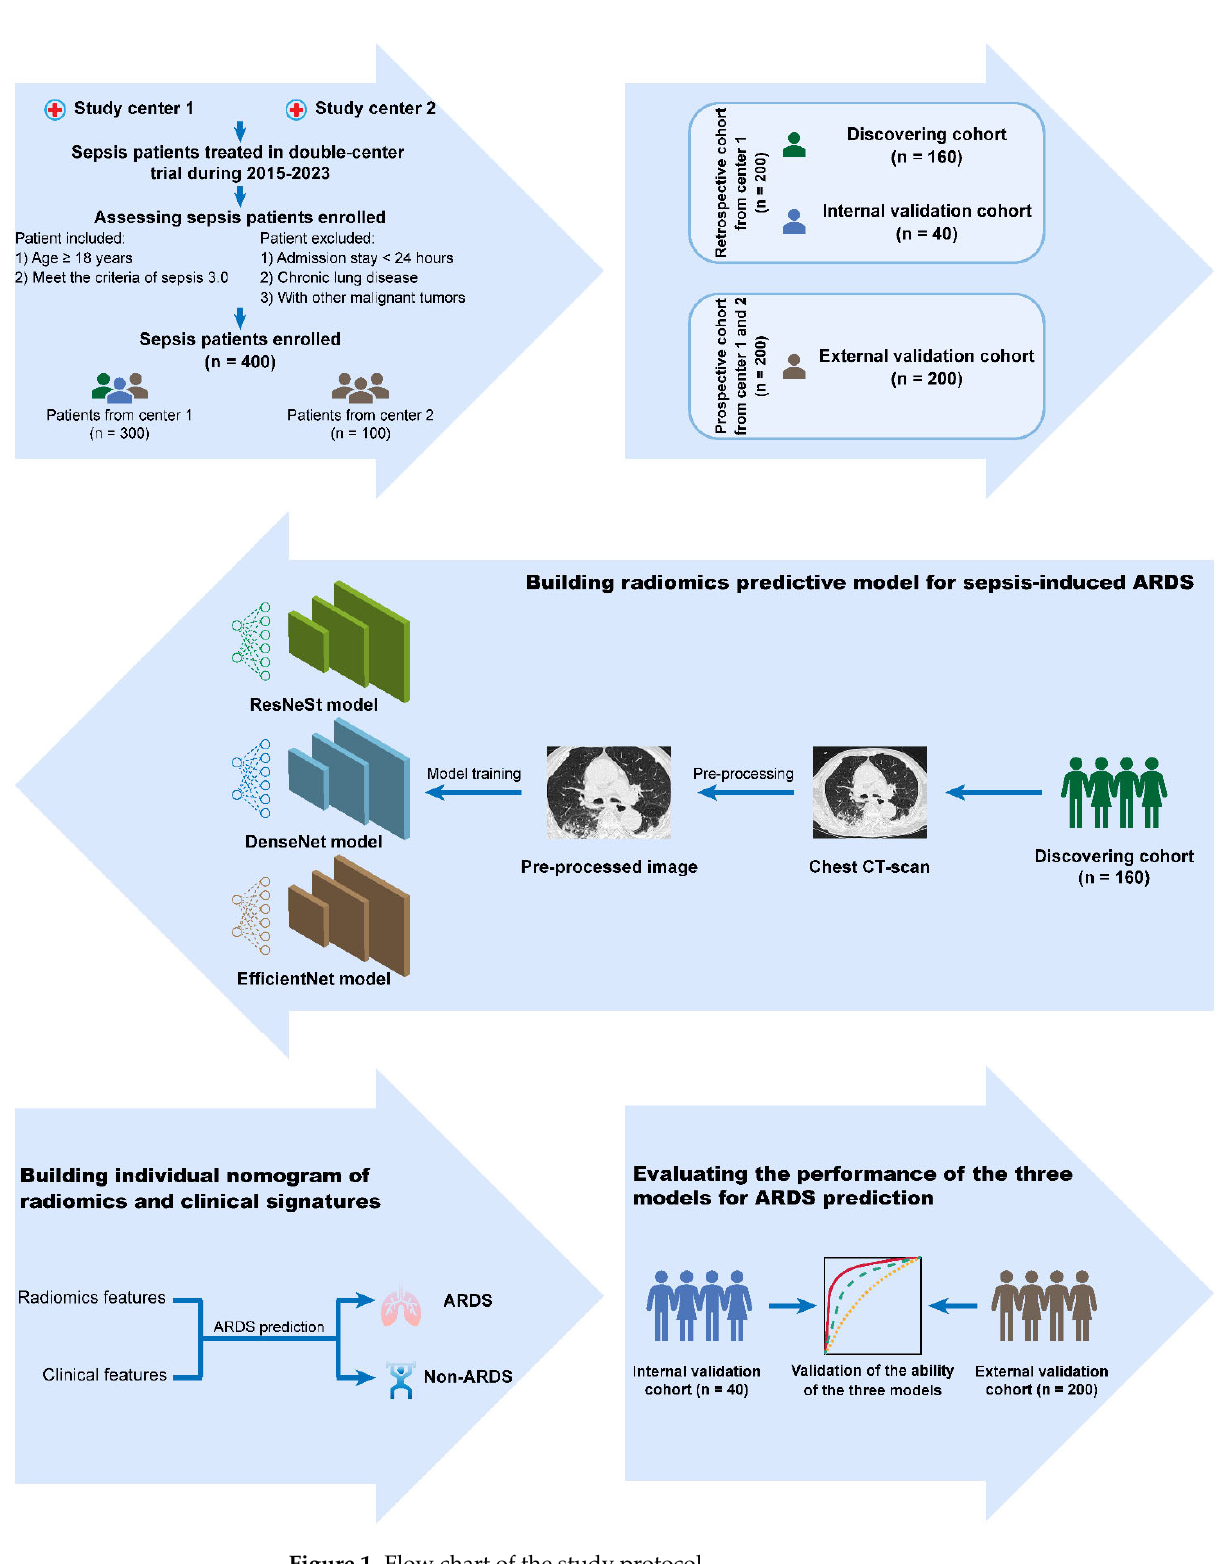
Figure 1. Flow chart of the study protocol.